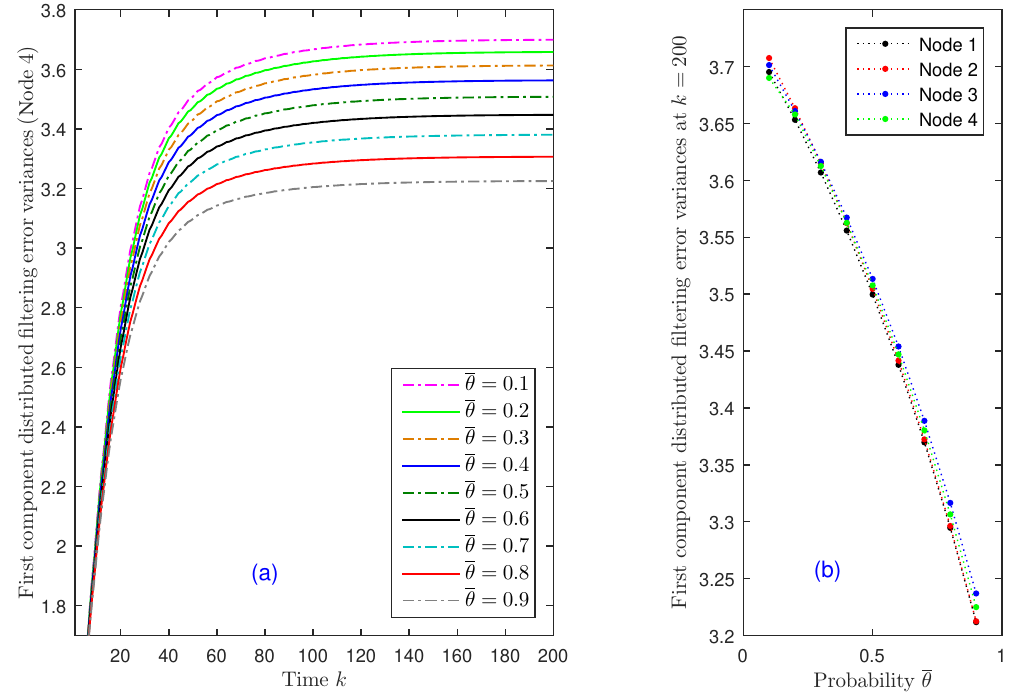
Figure 3. Distributed filtering error variances: ( a ) for θ = 0.1 to 0.9, in Node 4; ( b ) at k = 200, versus θ , in all